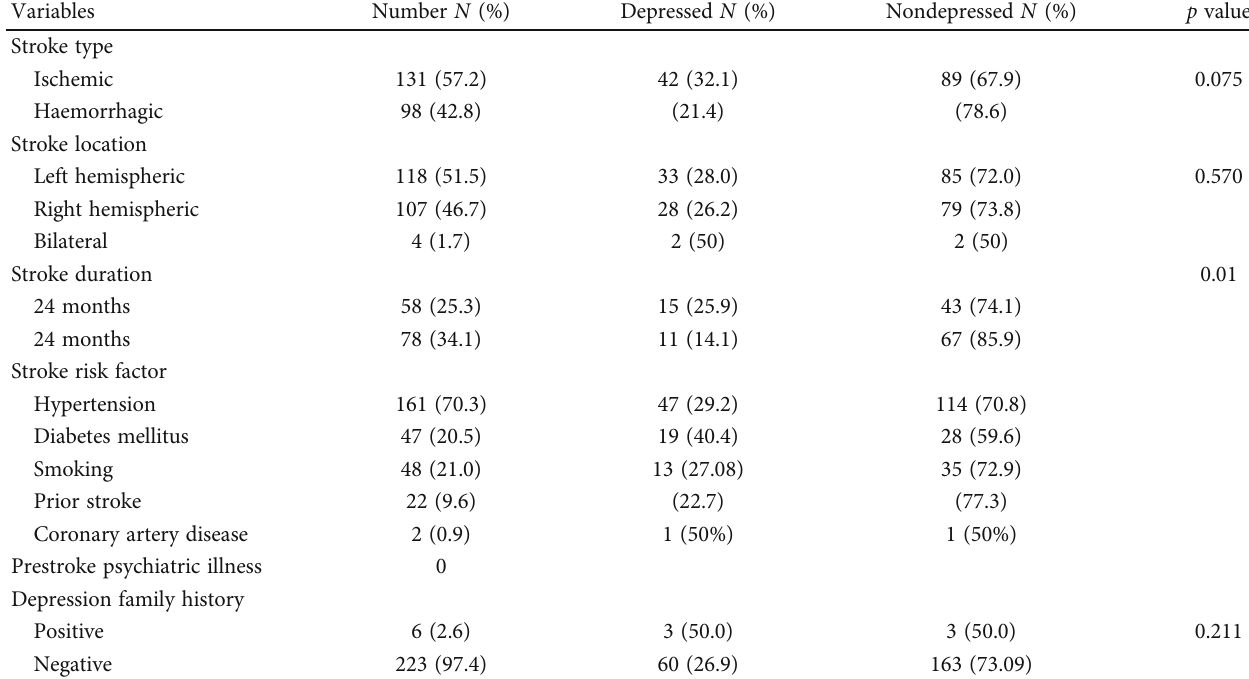
Table 2: Distribution of PSD in relation to some clinical and anatomic characteristics of stroke in study respondents at the neurology clinic of Zewditu Memorial Hospital in Addis Ababa, Ethiopia (total N = 229